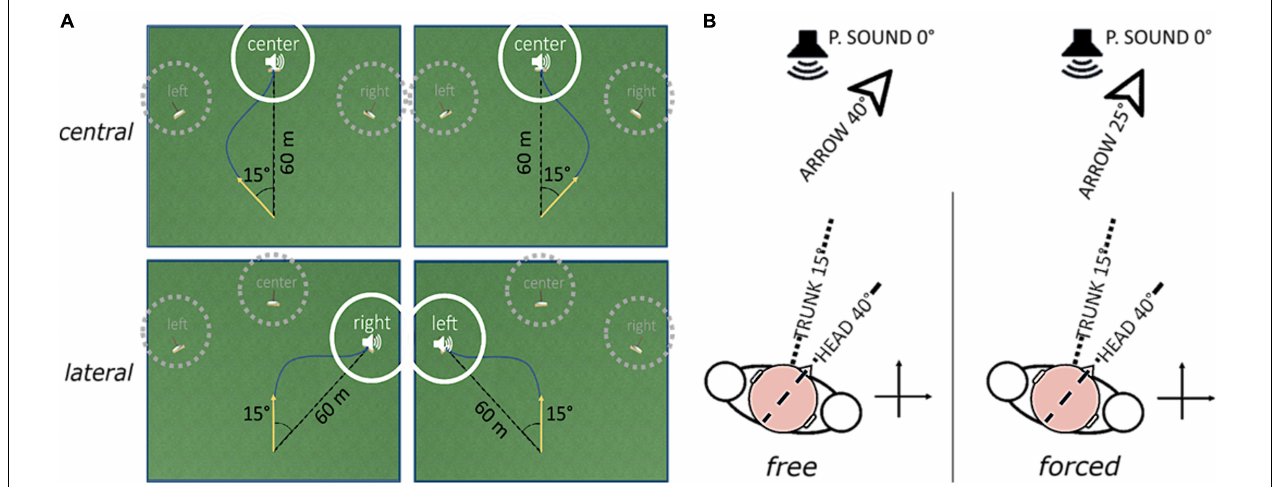
FIGURE 2 | Schematic description of how the experimental factors “direction” (A) and “coordination” (B) define the game condition. Panel (A) shows the virtual playfield and two examples of possible arrow trajectories (dark blue line) for each “direction” level. The yellow arrow highlights the starting arrow direction. Targets in dotted gray circles are inactive during the trial; the only active target is the one in full white circle. Examples on the same column show conditions where the relative position of arrow and target is the same, but the absolute target position (i.e., the “direction” level) is different. Panel (B) shows the relationship between body positions, arrow direction and perceived source position according to each “coordination” level. Head yaw, trunk yaw, and arrow direction are highlighted by, respectively, a dotted line and a dashed line. P.SOUND means perceived sound position. With forced coordination, immobilization of the trunk is demanded, and the arrow direction is given by the difference between head and trunk